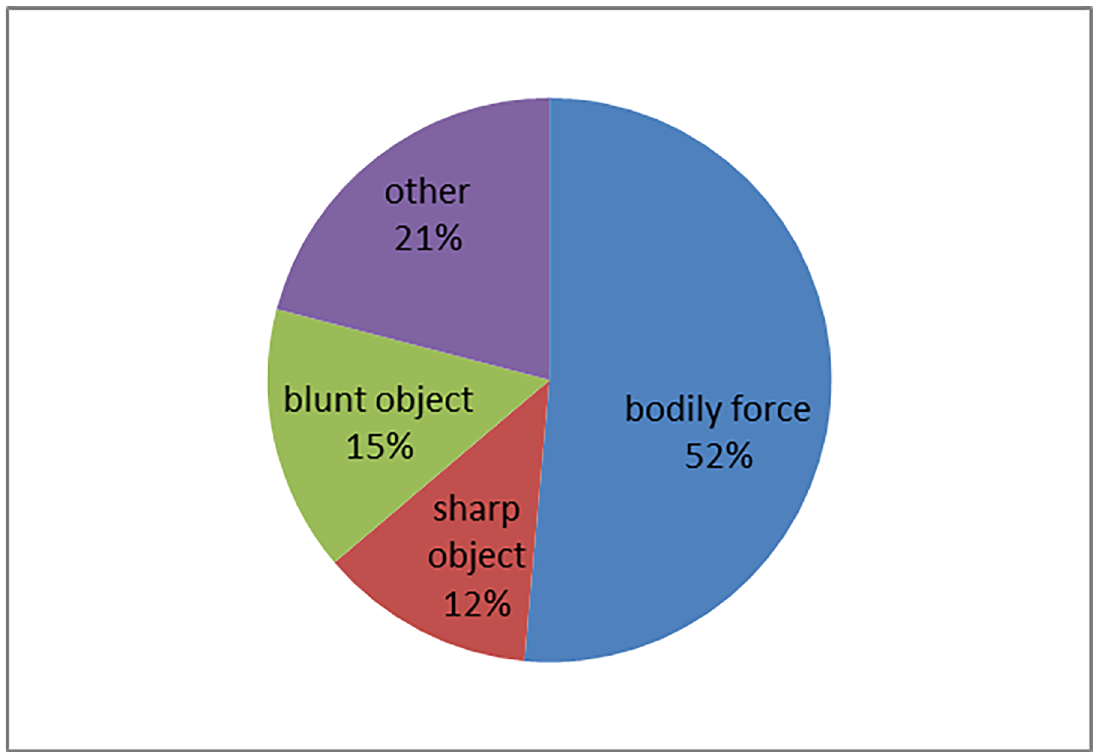
Fig 5. Type of violence used.